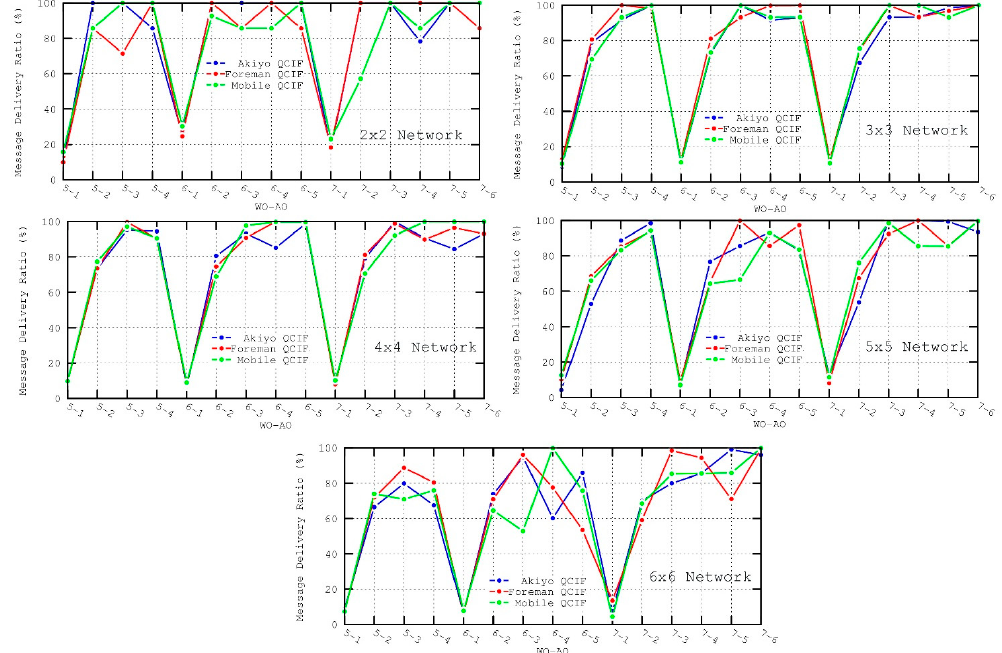
Figure 12. Throughput metric for the different scenarios.